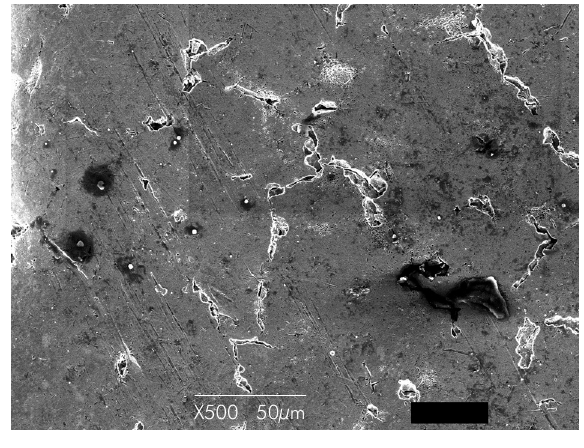
Figure 6. Photomicrograph from Group RM at 500x magnification.